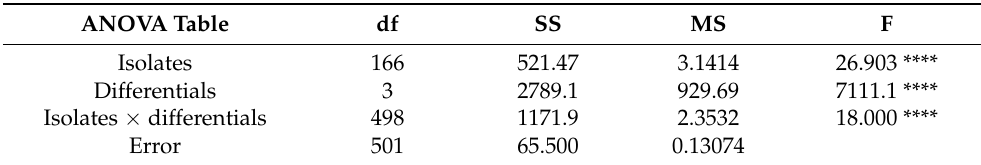
Table 4. Analysis of variance of the interaction between Pyrenophora tritici-repentis wheat differentials and isolates under greenhouse